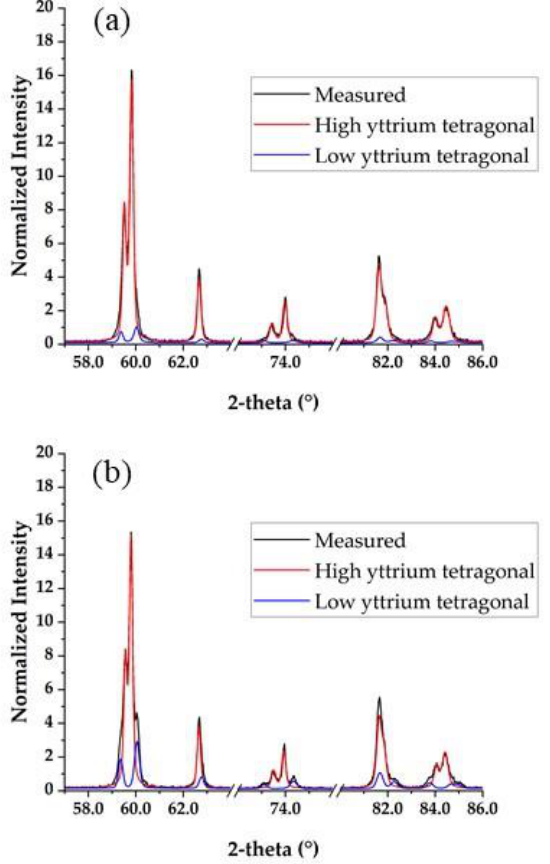
Figure 4. X-ray diffraction patterns of: ( a ) 5Y-SS-1.9, ( b ) 5Y-CS-1.9. Table 4. Tetragonality, Y 2 O 3 contents (calculated by Equations (2) and (3)) and phase contents (Rietveld).